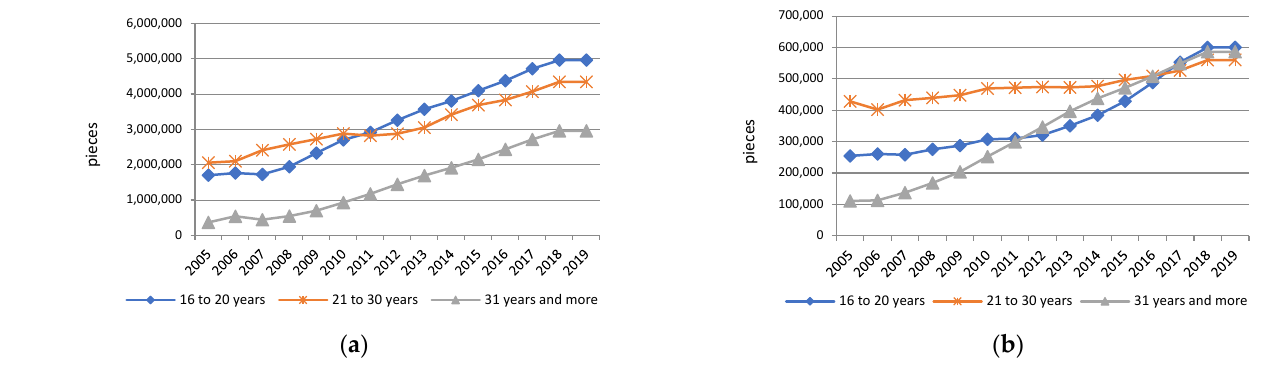
Figure 4. Number of cars over 15 years old ( a ) passenger cars; ( b ) lorries [44].